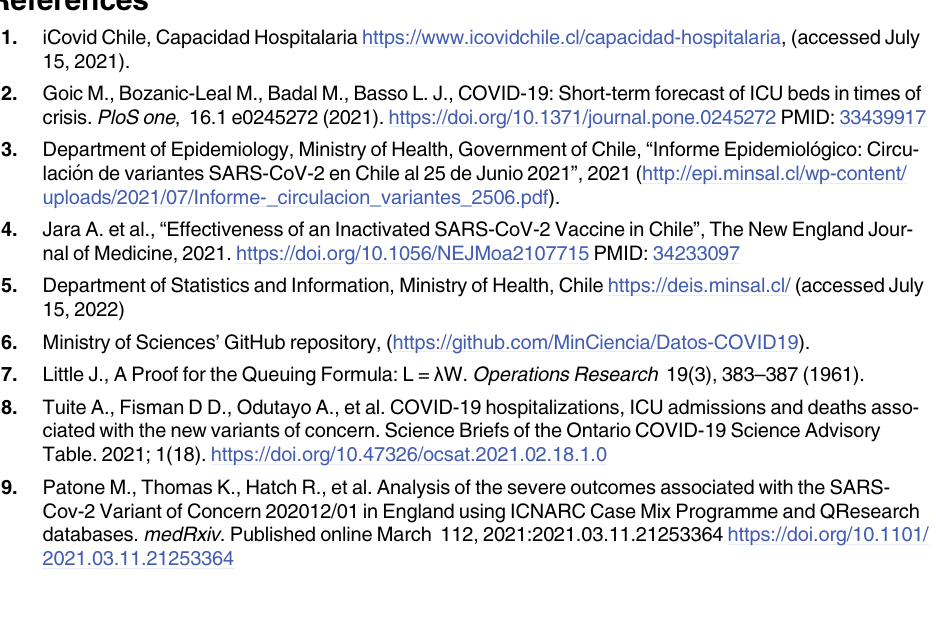
S3 Table. Mean square error—Comparative fit of the original vs variant-adjusted queueing models. For each age bracket, the mean square error between the expected and observed ICU occupancy during 2020, and during 2021, ignoring and incorporating